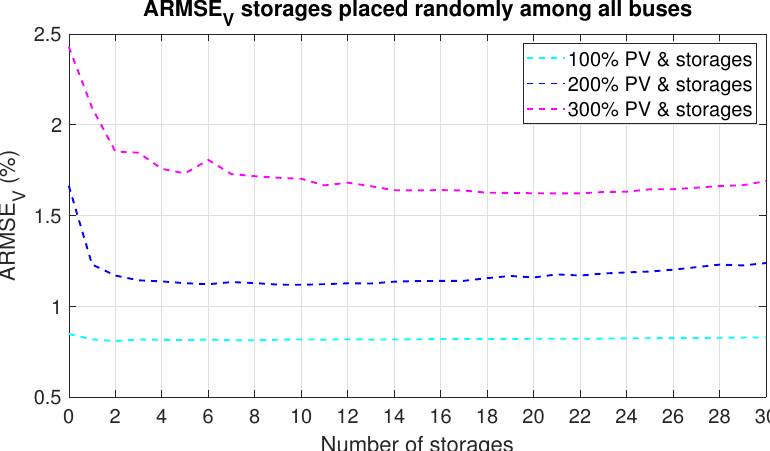
Figure 12. ARMSE of voltage across all buses and over a week for random distribution among all